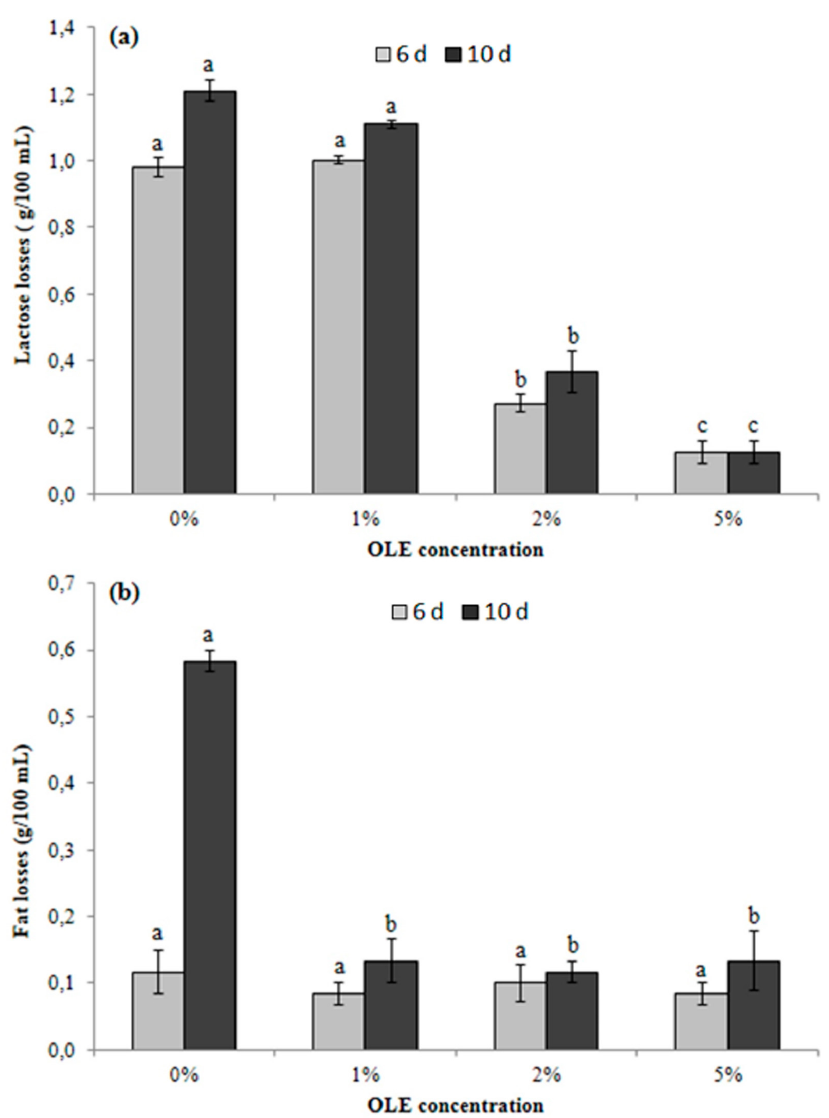
Figure 5. Losses of lactose ( a ) and fat ( b ) in milk samples containing 0%, 1%, 2%, and 5% of olive leaf extract (OLE) after 6 and 10 d of refrigerated storage. Bars indicate the standard error of the mean. Columns representing the same time (6 or 10 d) followed by different letters are significantly different according to Fisher’s least significant difference test ( p < 0.05).